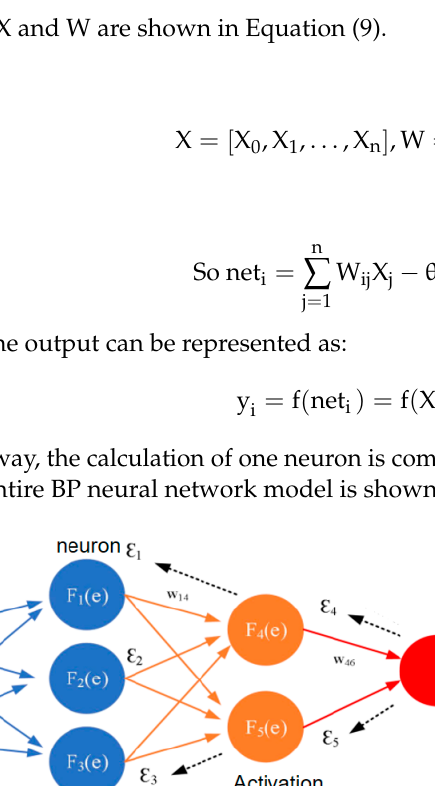
Figure 10. Schematic diagram of back propagation neuron calculation.